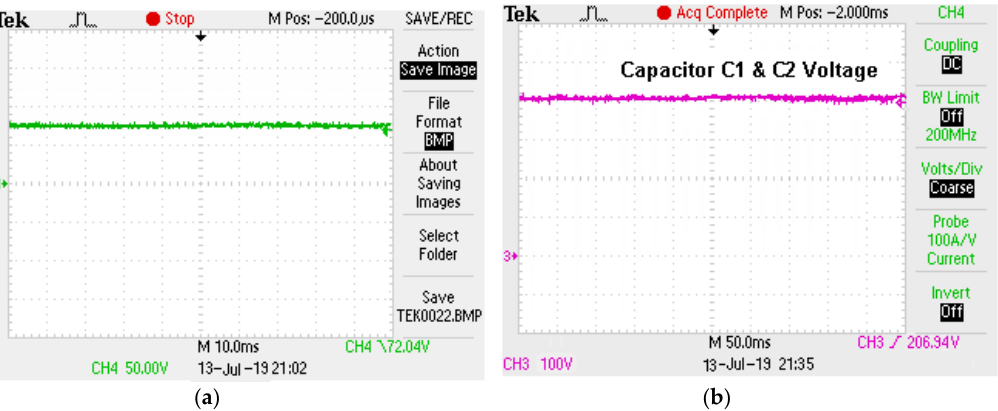
Figure 21. Experimental results: (a) solar photovoltaic array voltage; (b) voltage across capacitor in a Z-source network.